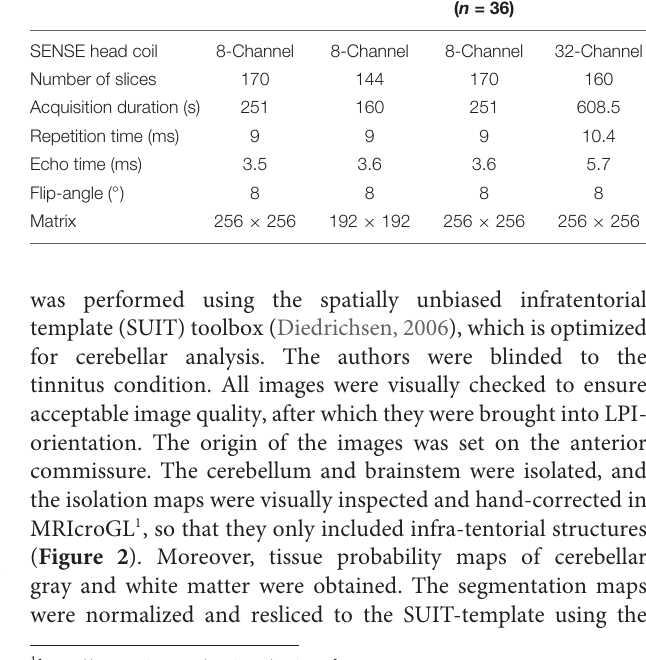
Frontiers in Neuroscience |